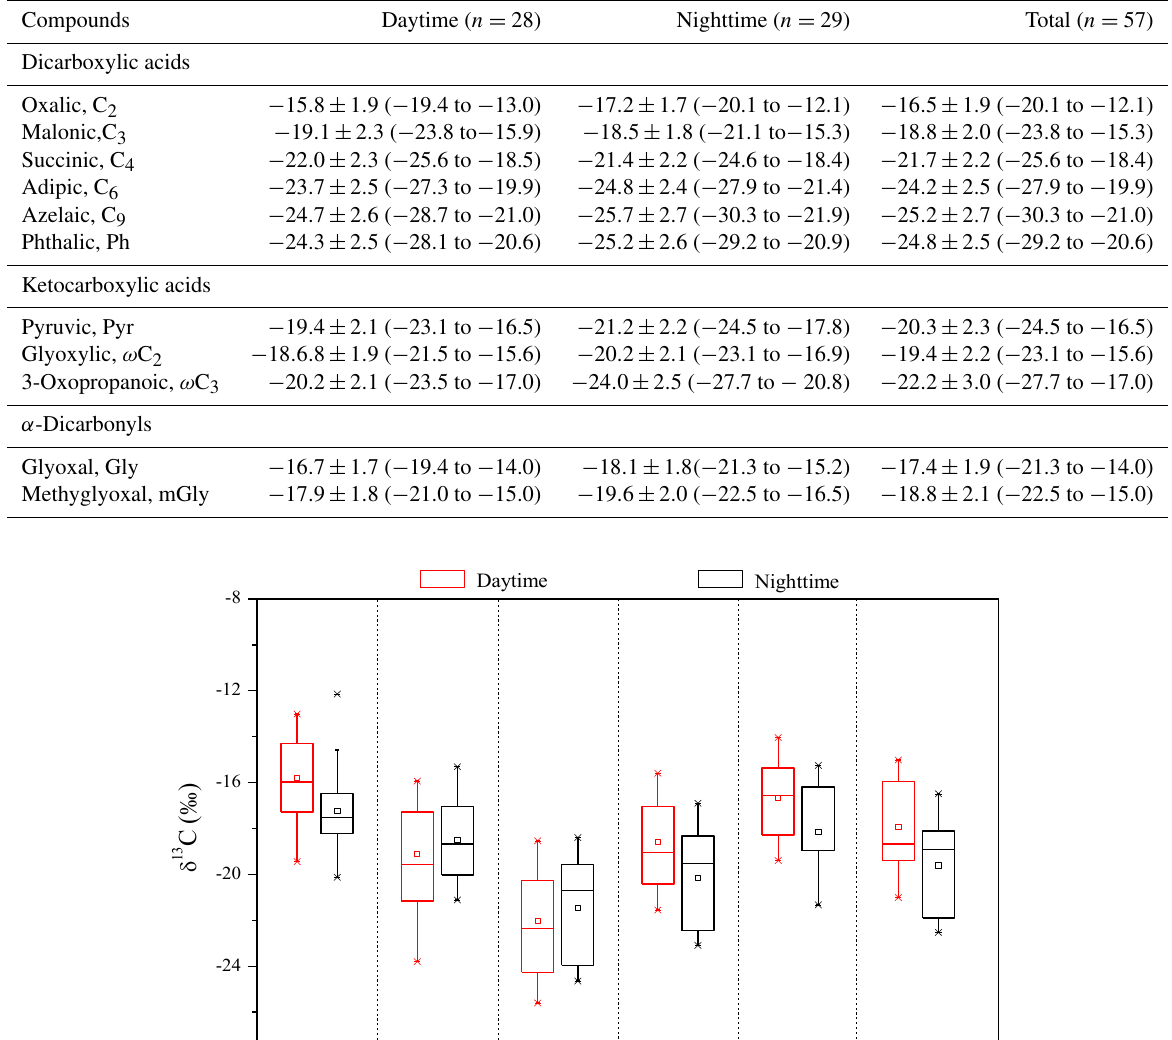
Table 5. Stable carbon isotopic compositions ( δ 13 C, ‰) of major dicarboxylic acids and related SOA in PM 2 . 5 of Mt. Tai in the North China Plain.